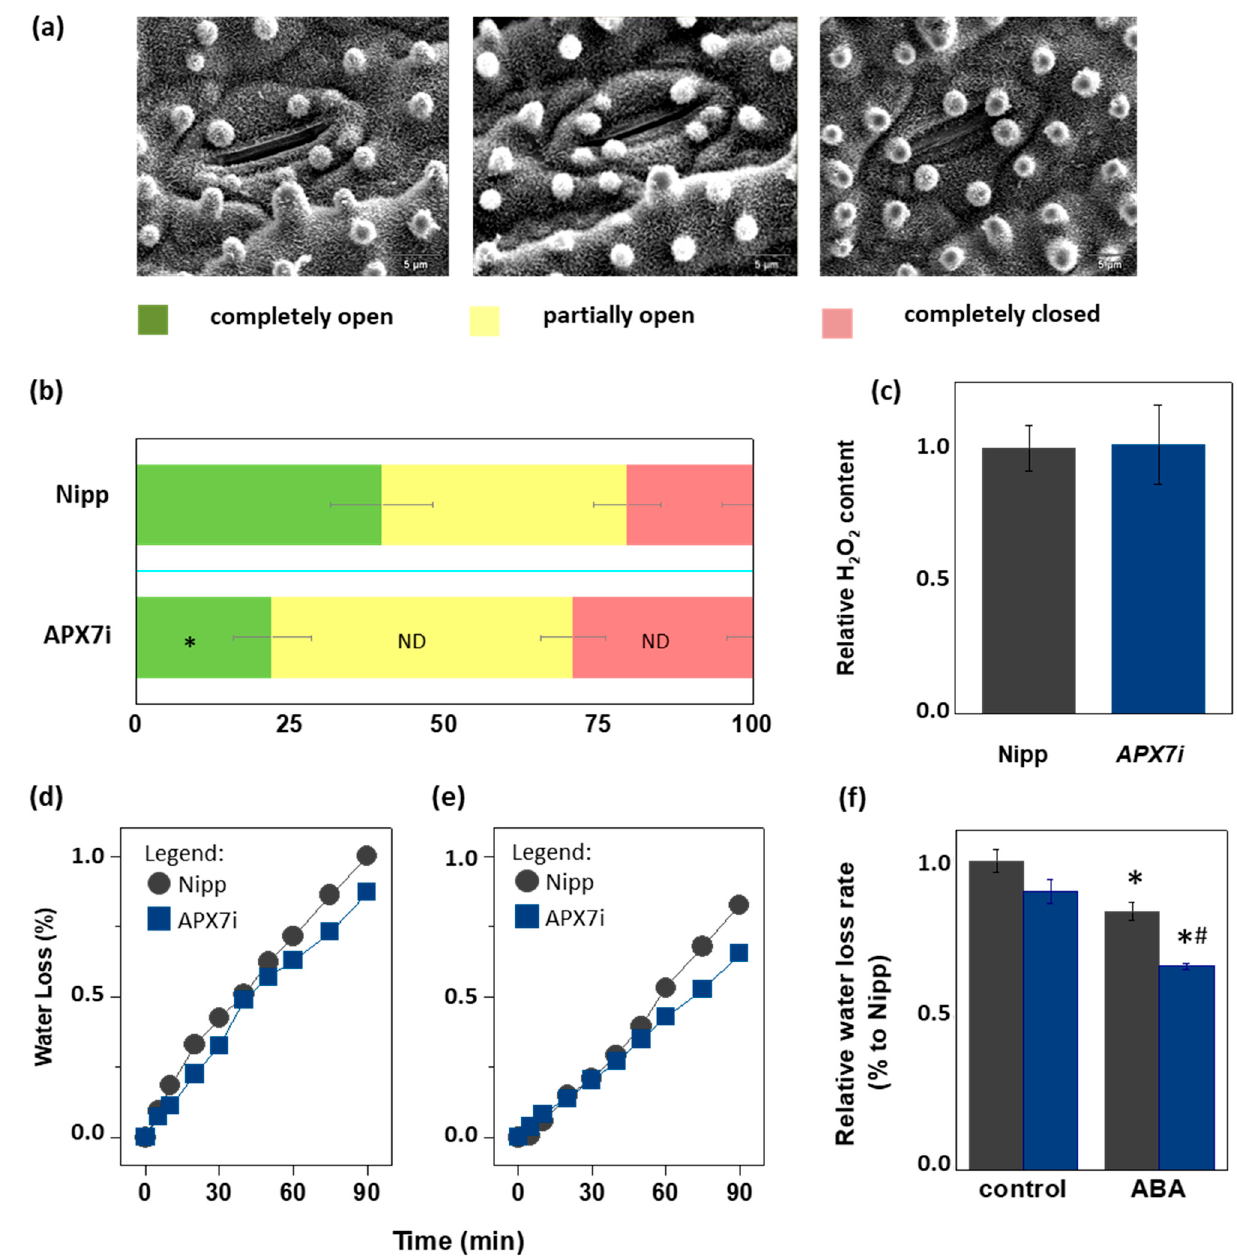
Figure 7. Effect of chloroplastic APX silencing in stomata opening and in leaf desiccation. ( a ) Environmental scanning electron microscopy images of three levels of stomatal opening. ( b ) Quantification of the percentage of the three levels of stomatal opening in leaves from Nipponbare (Nipp) and APX7i 30-day-old plants ( n = 200 stomata in the abaxial side of four middle leaves for each line evaluated). * indicates populations significantly different from Nipp plants with p < 0.05, and ND indicates no difference. ( c ) The relative content of hydrogen peroxide in leaves from Nipp (grey) and APXi (blue) leaves. The values represent the average ± SE of at least five independent experiments. ( d , e ) Water loss of leaves detached from plants under control conditions (treated with water) and treated with ABA 100 µ M, respectively. For each repeat, leaves of 30-day-old plants were used in a triplicate experiment ( n = 3). The water loss rate of each condition was quantified in panel ( f ). Grey indicates Nipp, and blue indicates APX7i plants. * indicates populations significantly different from the control condition, and (#) indicates populations significantly different from Nipp plants with p < 0.05.